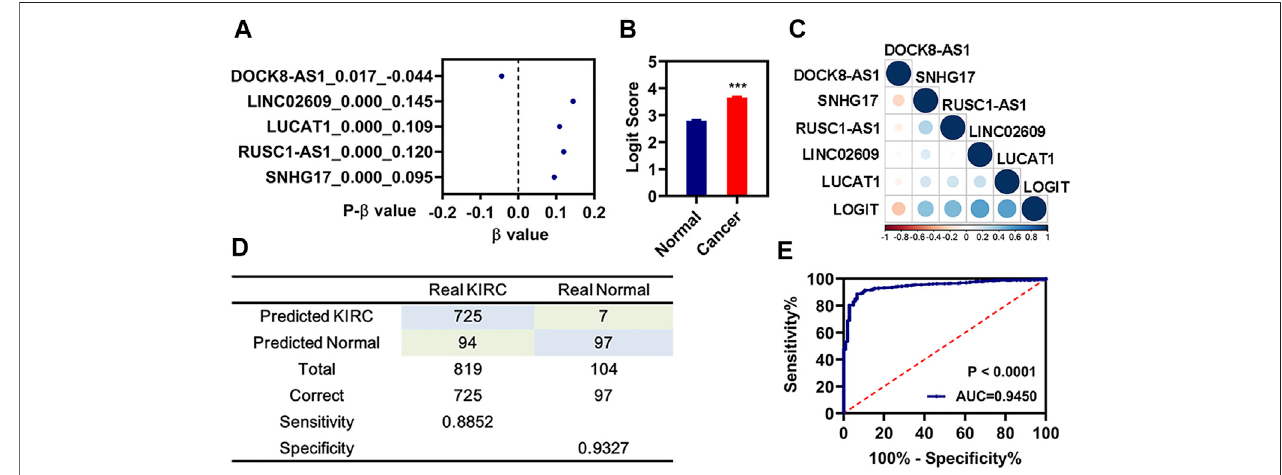
FIGURE 6 | Diagnosis model constructed by those 5 FR-DELs. (A) β value of those 5 FR-DELs analyzed by stepwise logistic regression. (B) Diagnostic values betweencancerand normal. (C) Correlationanalysisforthe expression ofthose 5FR-DELs and diagnostic values. (D) Construction matrixofthe classi fi cation resultsof thediagnosticmodel. (E) ROCcurvesforevaluatingthepredictiveperformanceofthediagnosticmodel.* p < 0.05,** p < 0.01,*** p < 0.001.FR-DELs,ferroptosis-related differentially expressed lncRNAs; ROC, receiver operating characteristic.